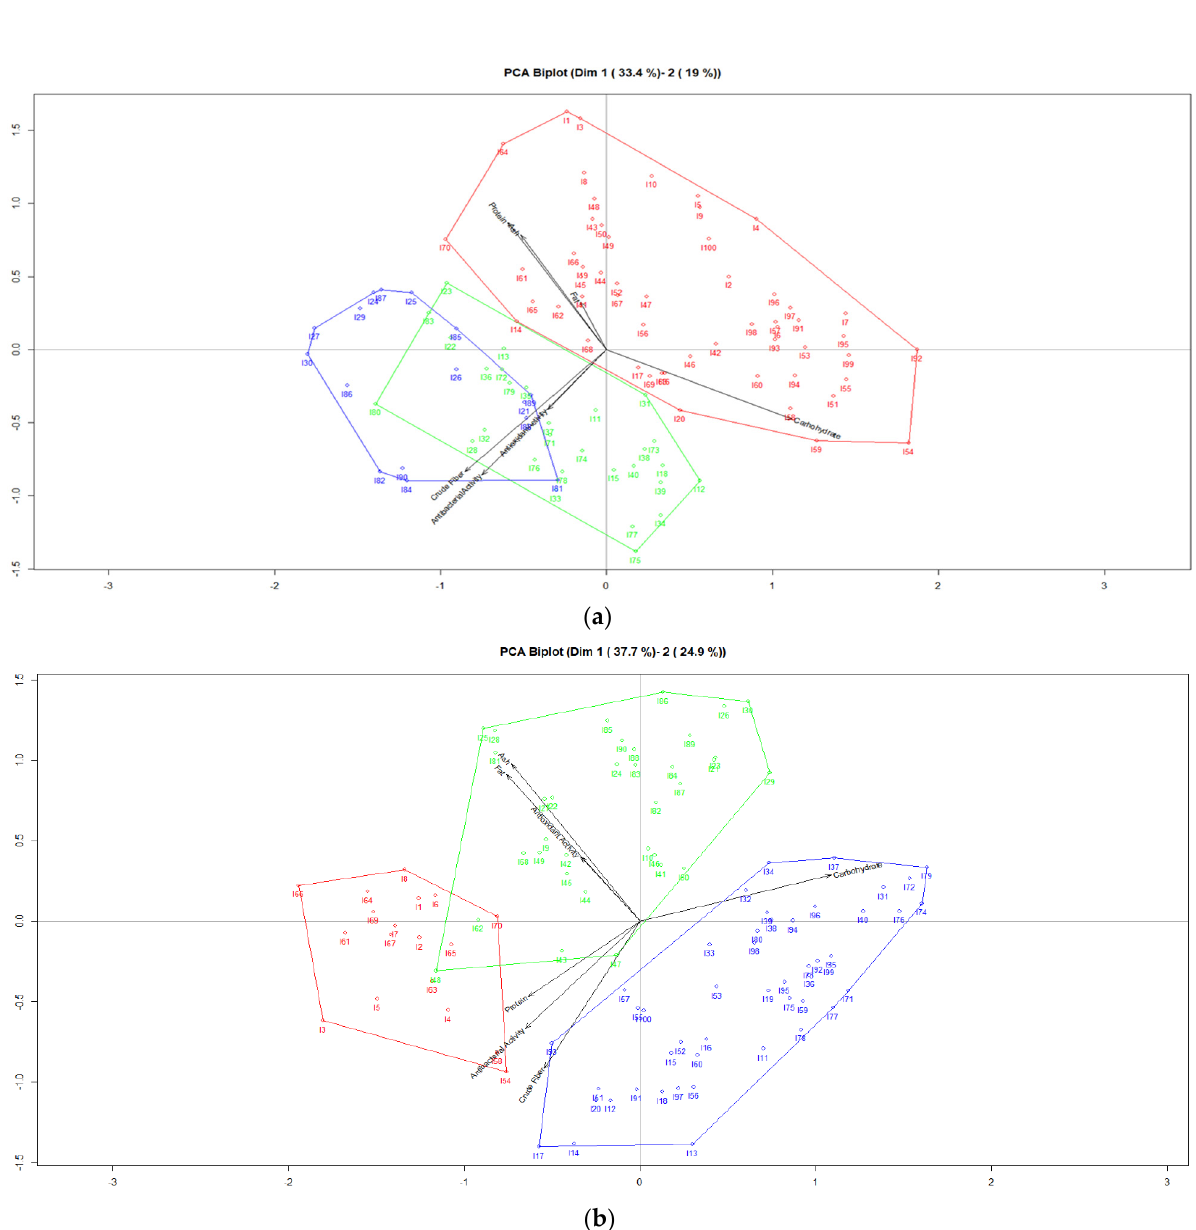
Figure 4. ( a ) PCA Biplot for biological properties of Pleurotus ostreatus , ( b ) PCA Biplot for biological properties of Pleurotus djamor .